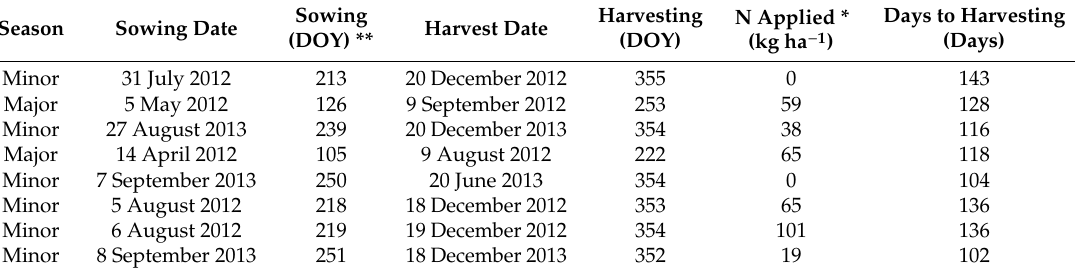
Table 1. Sowing date, harvesting date and fertilizer amount applied by the farmers in Atebubu-Amantin District.